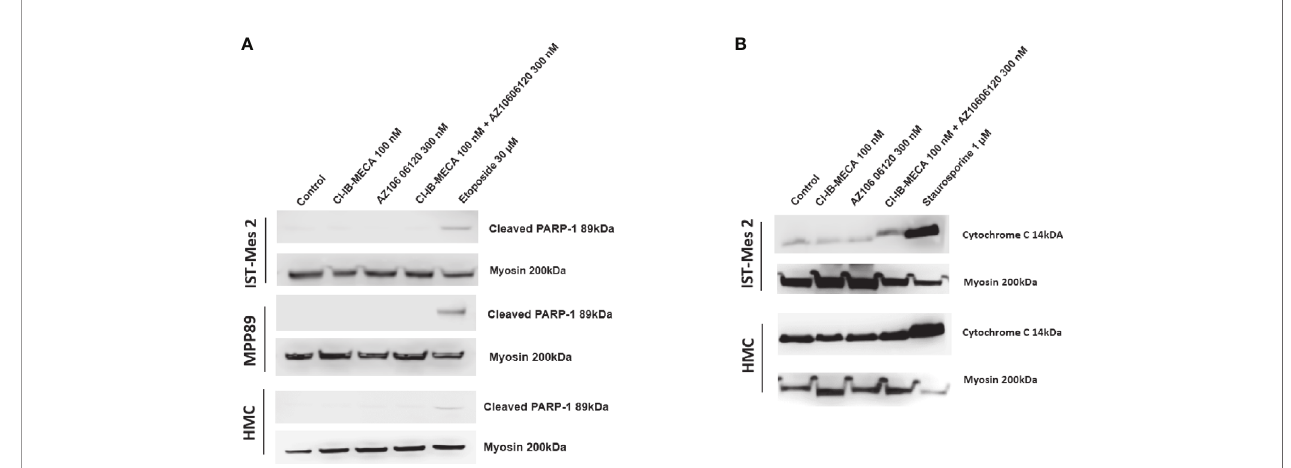
FIGURE 7 | Western blot analysis of cleaved PARP-1 and cytochrome C. (A) The expression levels of cleaved PARP-1 have been determined in IST-Mes2 and MPP89 cells as well as in HMC cells after 72 hours of treatment with Cl-IB-MECA (100 nM), AZ10606120 (300 nM), alone or in combination, in comparison to etoposide 30 µM. (B) The cytochrome C release has been determined in the subcellular fraction of IST-Mes2 and HMC cells after 72 hours of treatment with Cl-IB- MECA (100 nM), AZ10606120 (300 nM), alone or in combination, in comparison to staurosporine 1